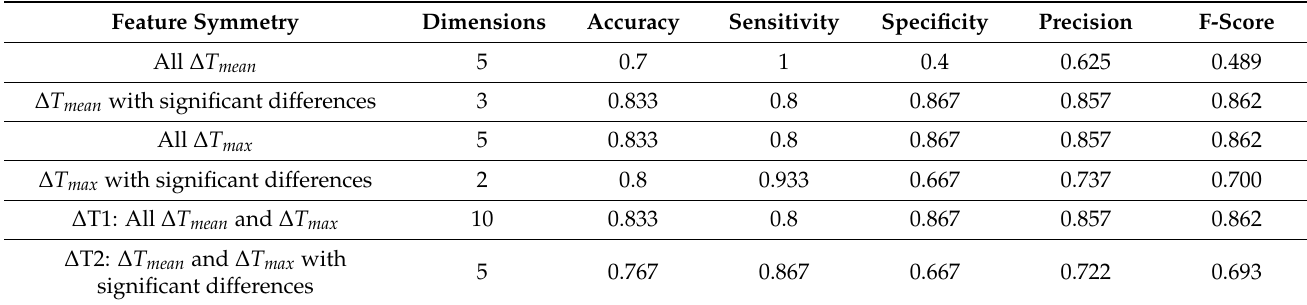
Table 8. Diagnostic performance of facial paralysis using different temperature feature symmetry combinations. Feature Symmetry